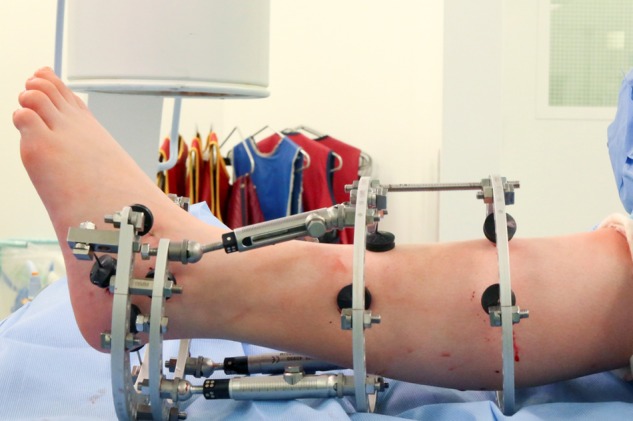
Clinical photograph of standard ring external fixator applied with TrueLok Rapid Struts, providing fixed ankle joint distraction